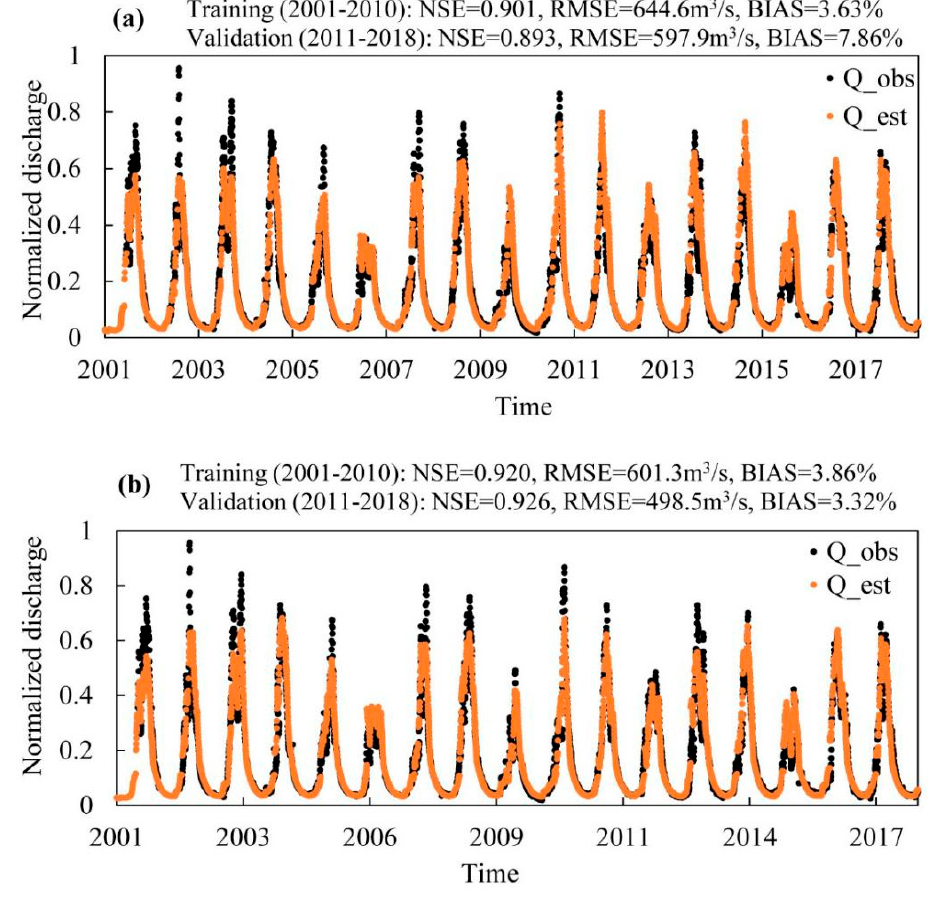
Figure 12. Normalized daily discharge estimates using the segmented TRMM precipitation data ( a ) and CMFD precipitation data for Nuxia basin ( b ) after the snow melting was considered.